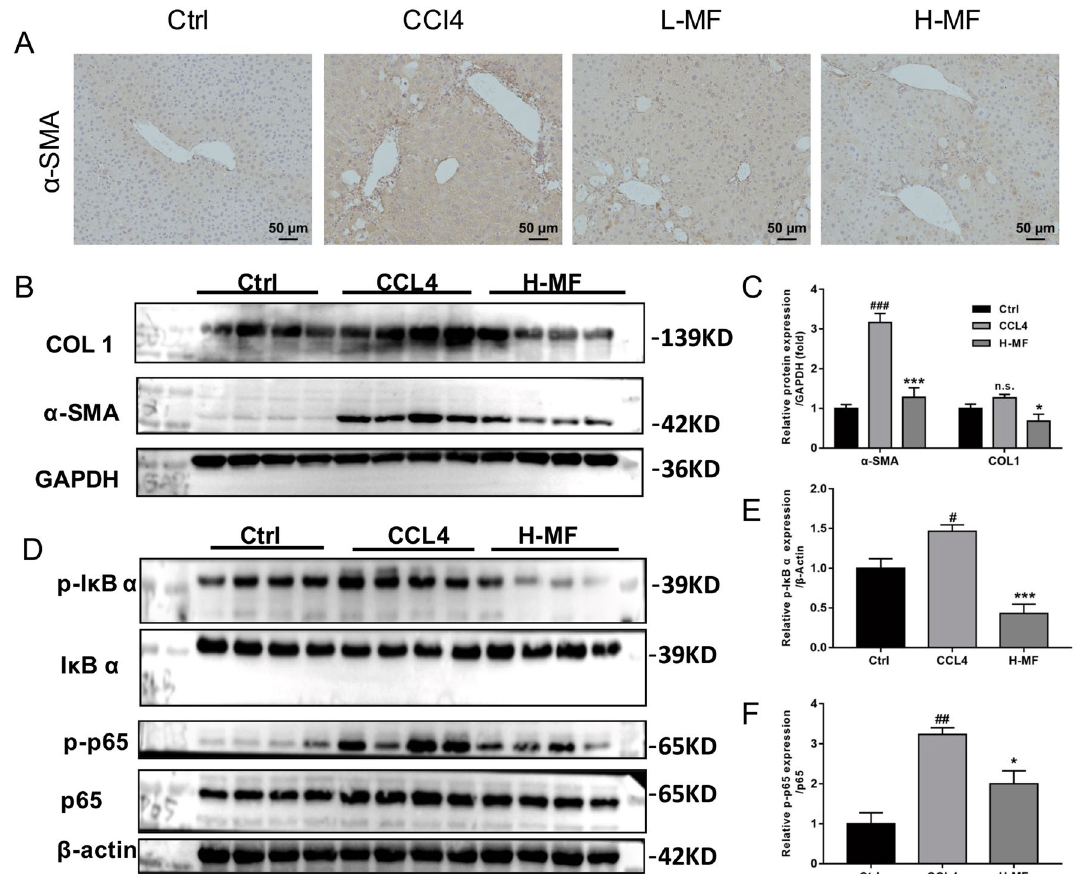
Figure 4. Mangiferin reduces CCl4-evoked hepatic α-SMA and COL1 protein levels and inhibits NF-κB pathway. ( A ) Immunohistochemistry staining of α-SMA. ( B ) Western blot analysis of α-SMA and COL1 protein. ( C ) Quantitation of western blot analysis of α-SMA and COL1 protein levels in ( B ). ( D ) Western blot analysis of p-IκB and p-p65 protein. ( E ) Quantitation of western blot analysis of p-IκB protein. ( F ) Quantitation of western blot analysis of p-p65 protein. GAPDH and β-Actin were assayed as an internal control respectively. All experiments repeated 3 times. The blots were cut prior to hybridisation with antibodies during blotting. # p < 0.05, ## p < 0.01 and ### p < 0.001, compared with control group. * p < 0.05 and *** p < 0.001, compared with CCl4 group. Ctrl, control group; CCl4, carbon tetrachloride treated group; H-MF, high dose of mangiferin (100